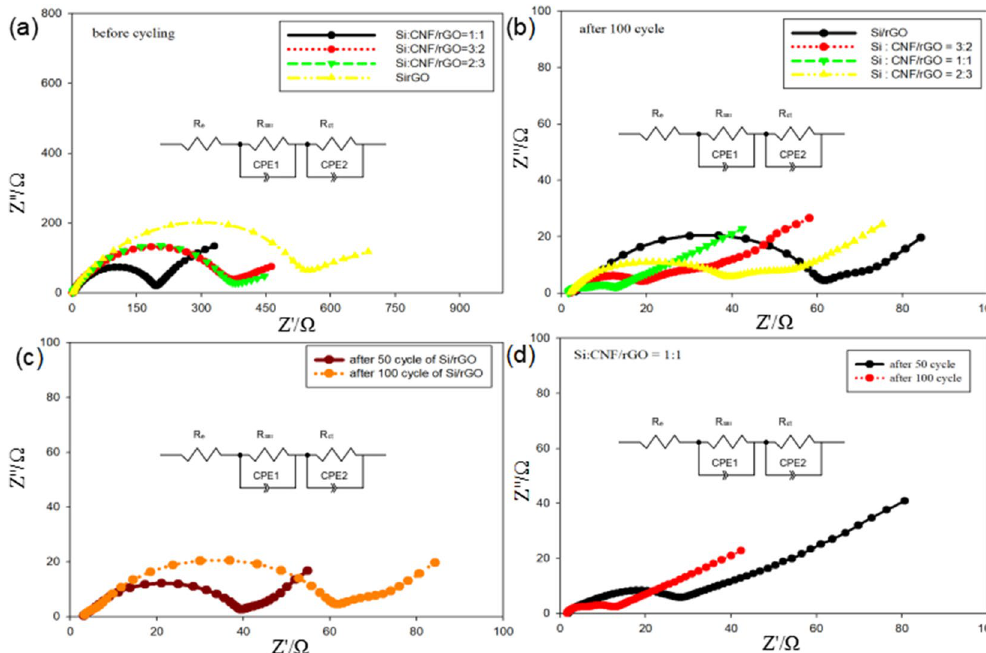
Figure 8. ( a ) Nyquist plots and electrochemical impedance spectra of the Si:CNF/rGO = 1:1, 3:2, and 2:3 and Si/ rGO composite anodes before cycling. ( b ) Nyquist plots and electrochemical impedance spectra of the Si:CNF/ rGO = 1:1, 3:2, and 2:3, and Si/rGO composites anode after cycling. ( c , d ) EIS curves of the Si/rGO composites anode ( c ) and Si:CNF/rGO = 1:1 composite anode ( d ) after the 50th and 100th